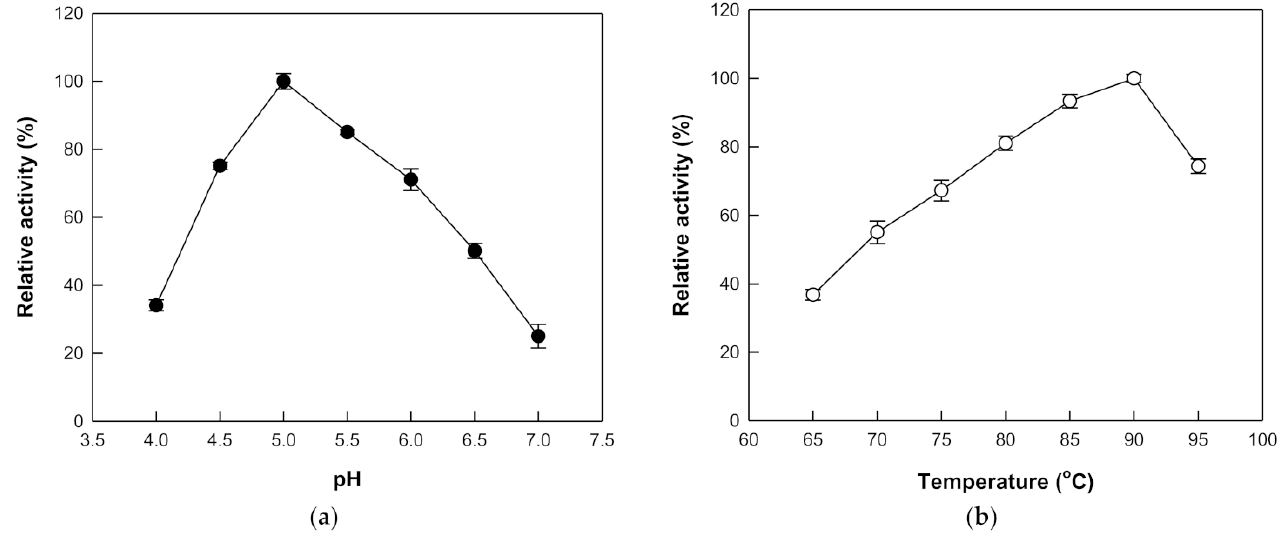
Figure 2. Effects of pH and temperature on the activity of β -galactosidase from T. uzoniensis. ( a ) Effect of pH. The reactions were performed at the indicated pH values with 1 mM p NP- β -D-glucopyranoside and 0.005 mg/mL of enzyme at 70 ◦ C for 10 min. ( b ) Effect of temperature. The reactions were per- formed at different temperatures in 50 mM CPB (pH 5.0) containing 1 mM p NP- β -D-glucopyranoside and 0.005 mg/mL of enzyme for 10 min. Data are represented as the means of triplicate experiments and error bars represent the standard